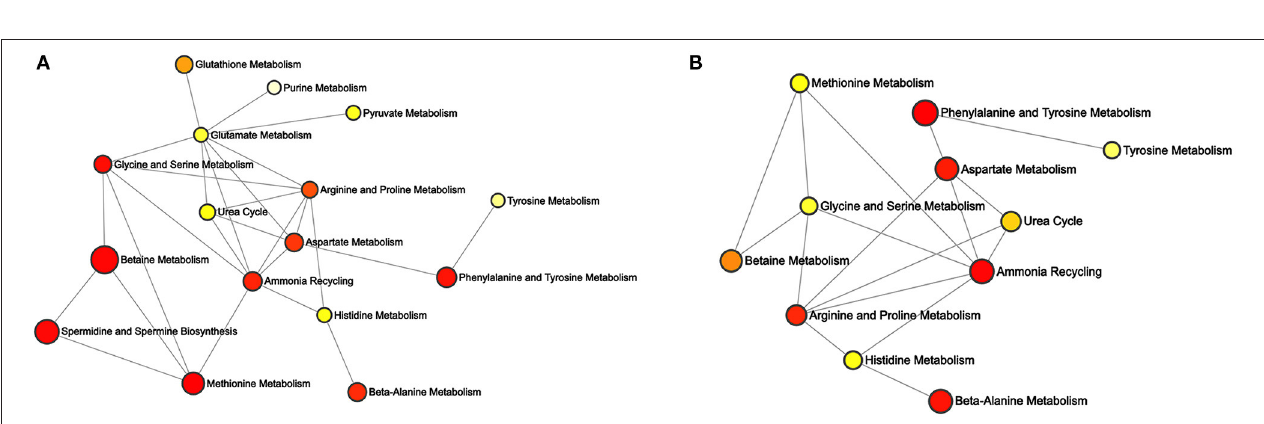
FIGURE 6 | Enrichment analysis of differential metabolites associated with the pathway. (A) Differential network between control and 6-BA group. (B) Differential network between control and KT